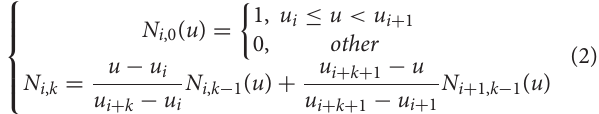
effectively meet the requirements of graphic shape representation and geometric design, is convenient for shape information transmission and image shape mathematical modeling, and can solve the modeling problem of free-form curves. To construct a B-spline curve model, a starting point, an ending point, and multiple control points must be defined. By changing the coordinates of the vertices of the polygon inscribed in the contour (i.e., control points), the shape of the B-spline curve can be changed accordingly to realize nerve bundle contour modeling (Zhong et al.,